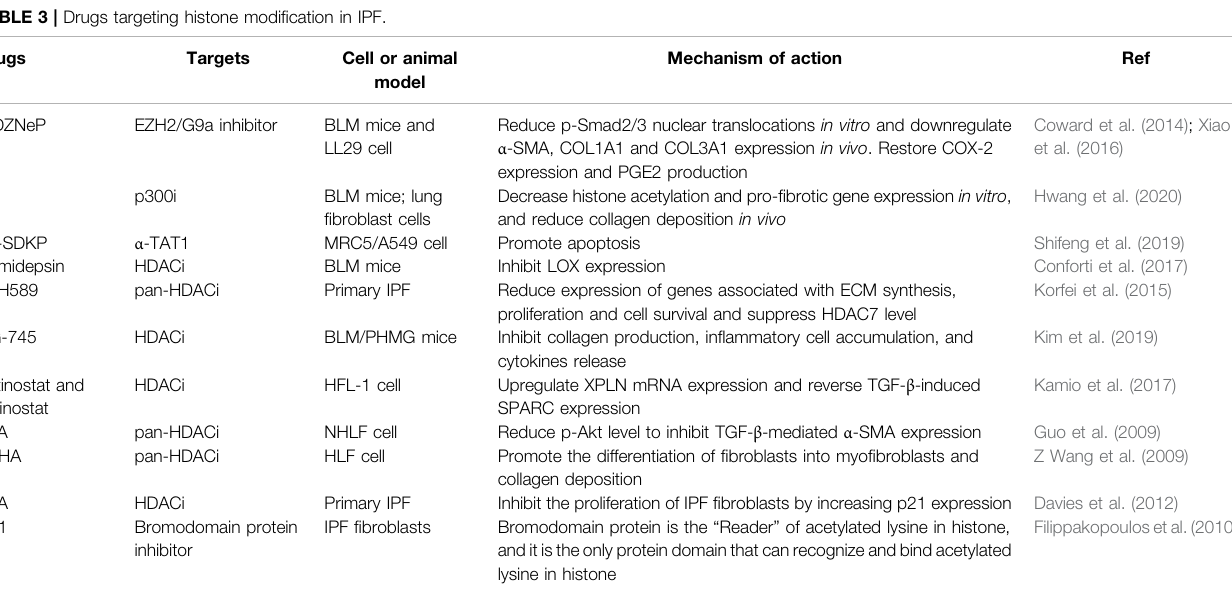
TABLE 3 | Drugs targeting histone modi fi cation in